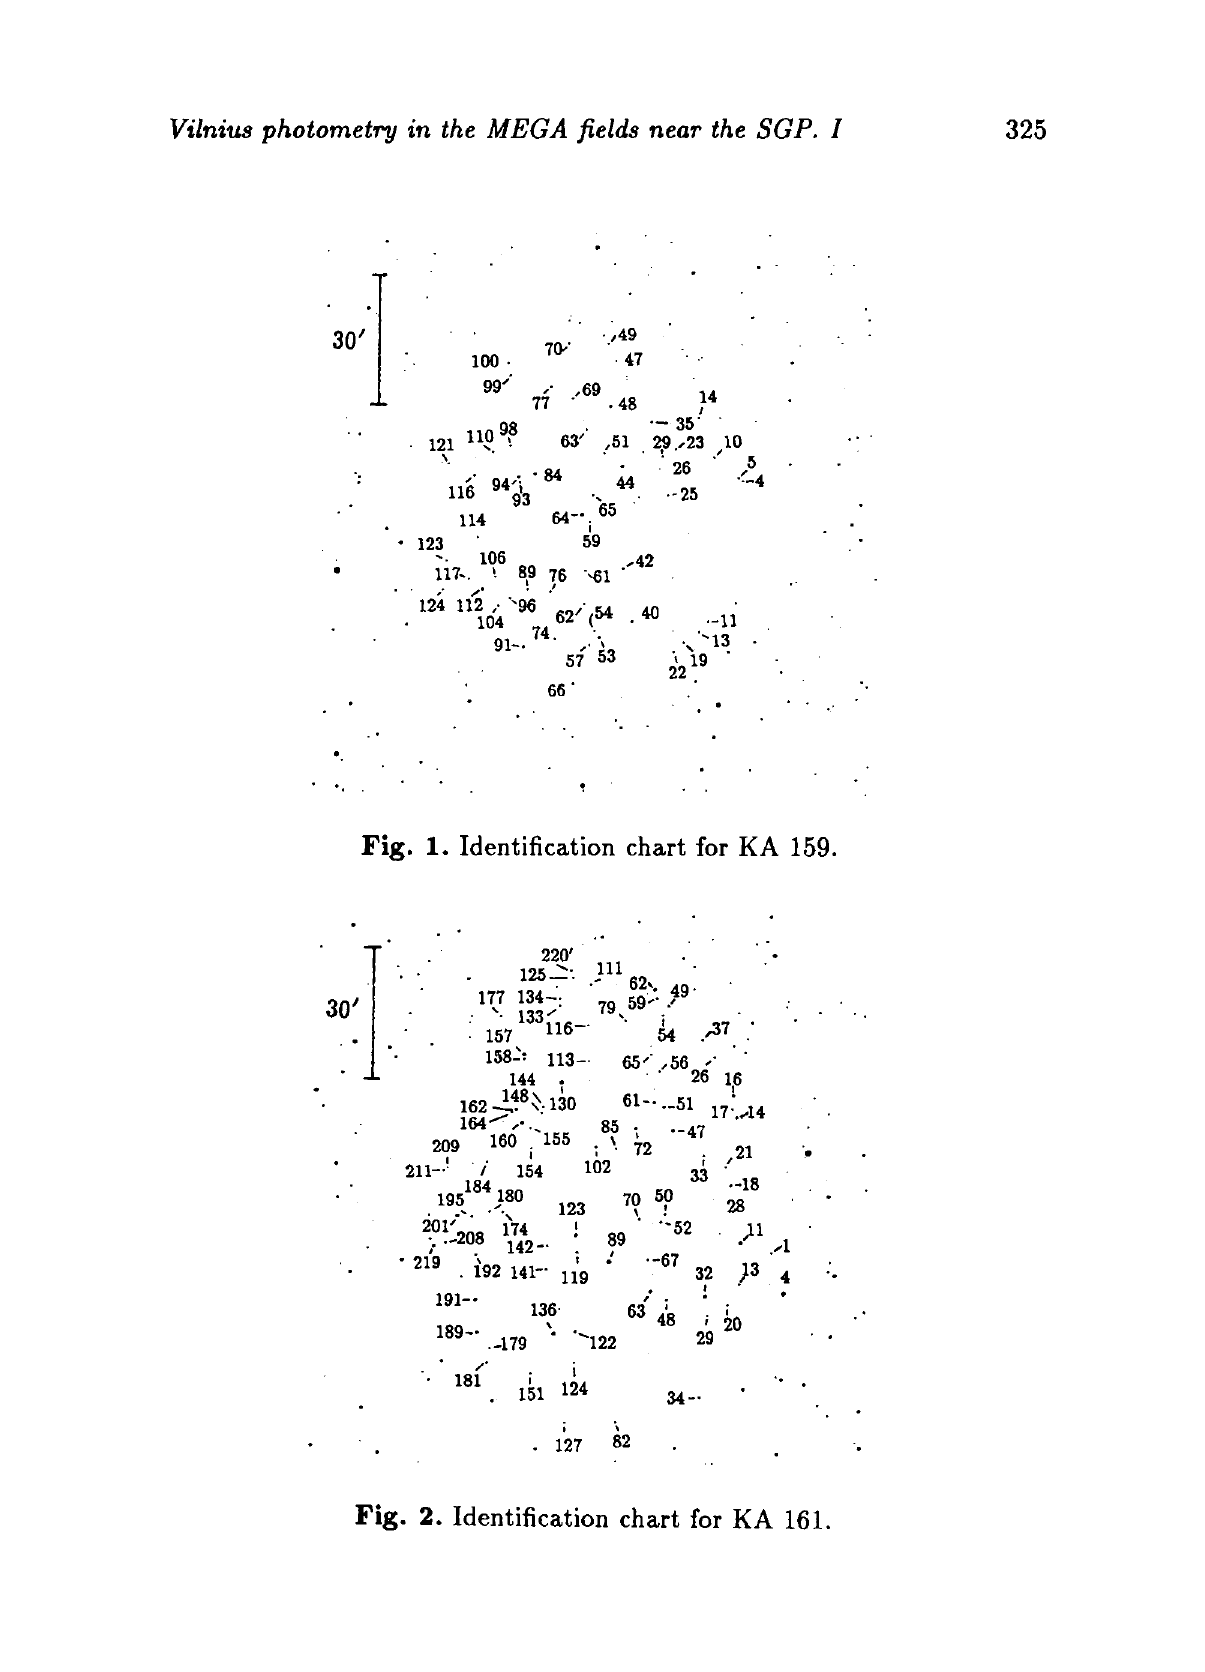
Fig. 2. Identification chart for Κ A